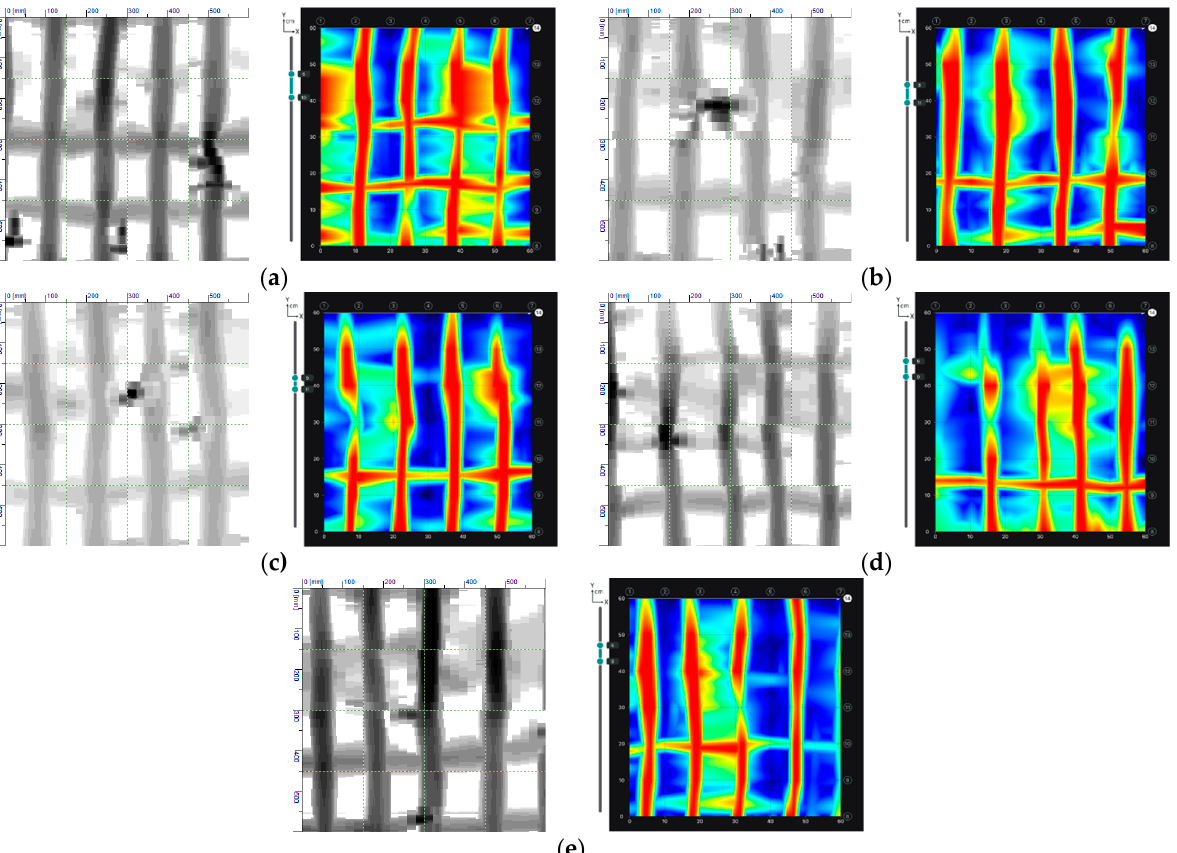
Figure 9. A comparison of the results of the reinforcement detection using electromagnetic and radar methods: ( a ) P1, ( b ) P2, ( c ) P3, ( d ) P4, ( e ) P5.